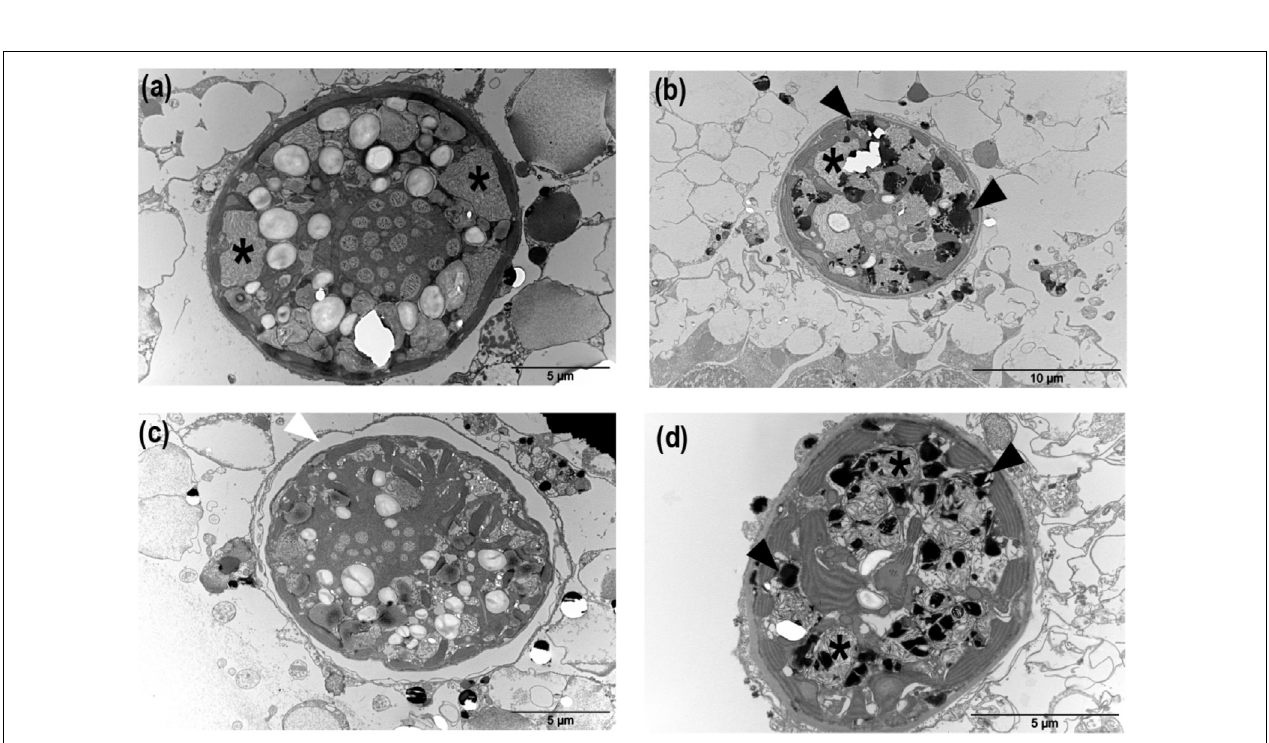
FIGURE 6 | Morphological structures corresponding to the main cellular responses induced in in hospite B. nutricula cells in control and heat-stressed colonies of Collozoum pelagicum . Transmission electron microscopy of C. pelagicum cross section in control T1 (a) , control T2 (b) at 21 ◦ C, and thermal stress T1 at 25 ◦ C (c) and thermal stress T2 at 28 ◦ C (d) . Asterisks: filamentous particles, black triangles: apoptotic bodies, white triangles: vacuolar matrix.